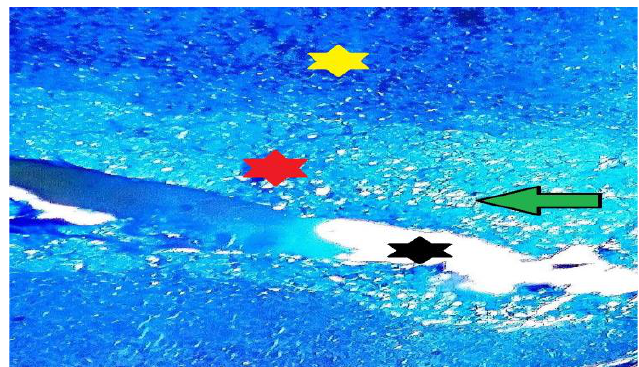
Figure 4. Histochemical section of medulla of squirrel adrenal gland showing medulla (red star), cortex (yellow star), chromaffin cells (green arrow) and central vein (black star). Potassium dichromate salts, methylene blue-eosin stain, 400×